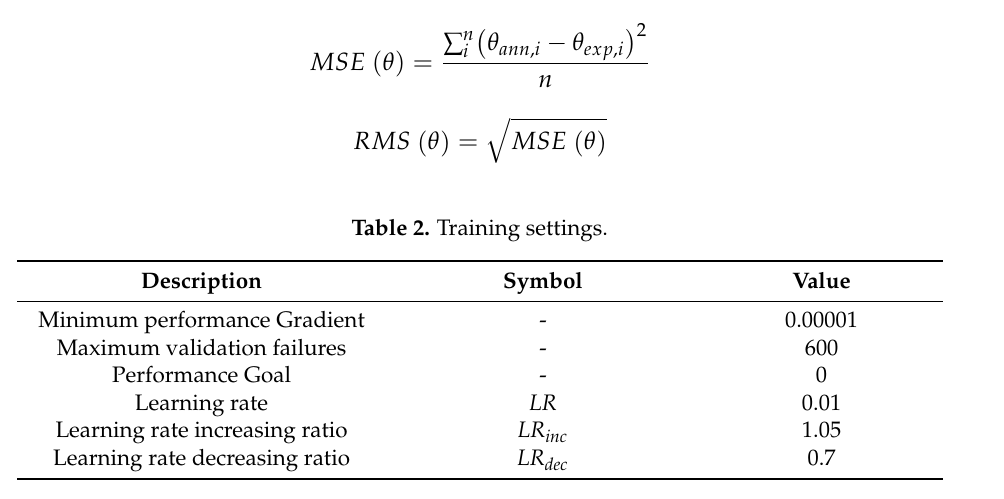
Table 2 are: “minimum performance gradient” represents the minimum accepted value of performance improvement; “maximum validation failures” is the maximum number of failures allowed along the network improvement and “performance goal” is the target of the performance function. During the training phase, simulation performances are checked on the Mean Squared normalized Error ( MSE , Equation (1)) and Root Mean squared Error ( RMS , Equation (2)), both based on the sum of squared errors (the difference between the ANN output θ ann,i and the corresponding experimental results θ exp,i ).